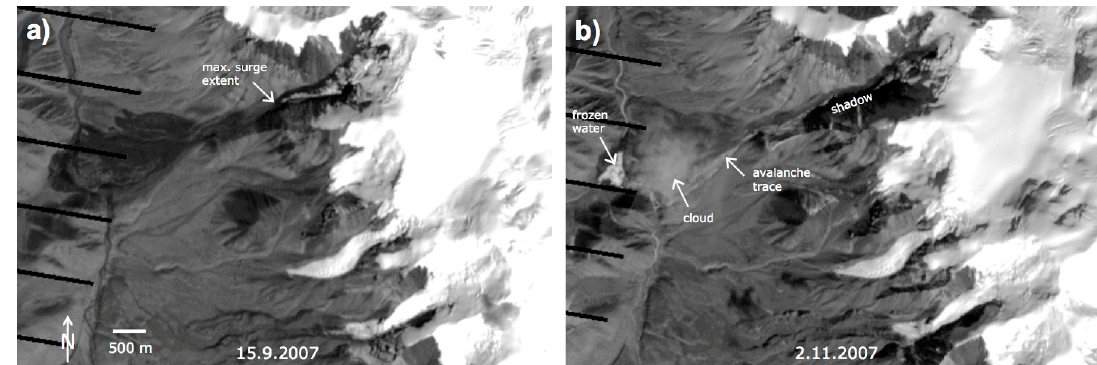
Figure 6. Two Landsat 7 ETM+ pan images showing the surging glacier in 2007: (a) before and (b) after the collapse. Image source: earthexplorer.usgs.gov.